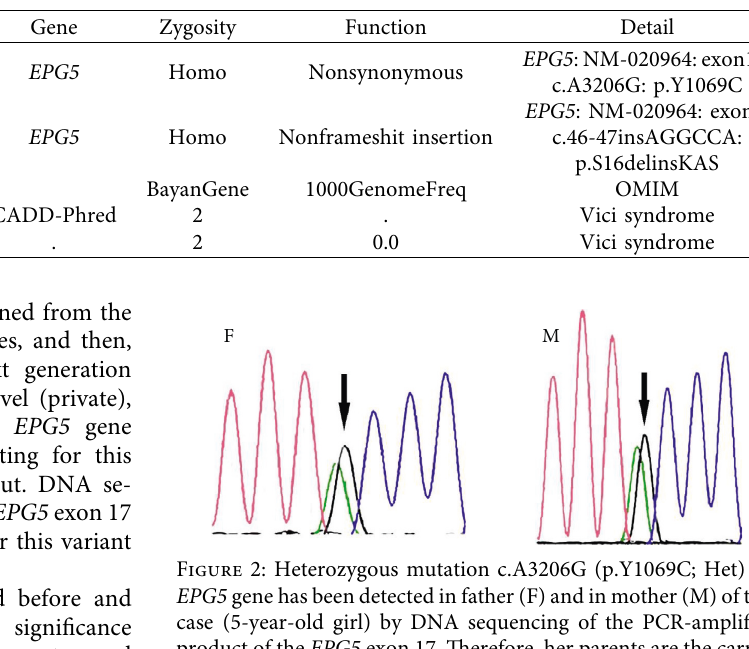
Figure 1: A 5-year-old girl with Vici syndrome. Table 1: Two novels (private), homozygous, missense, and nonframeshift insertion mutations in EPG5 gene detected by whole exome sequencing (WES) using next generation Illumina sequencing.